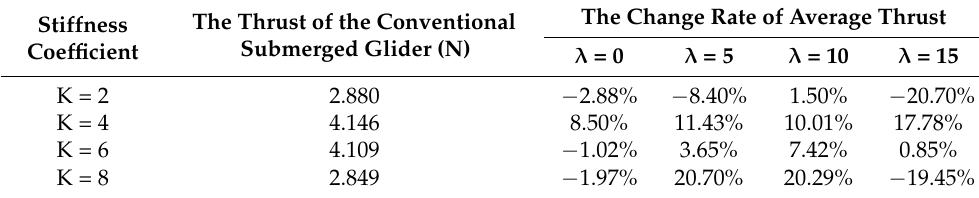
Table 9. The average thrust change rates of the SALL submerged glider under the different K and λ . The Thrust of the Conventional Stiffness Submerged Glider (N) Coefficient